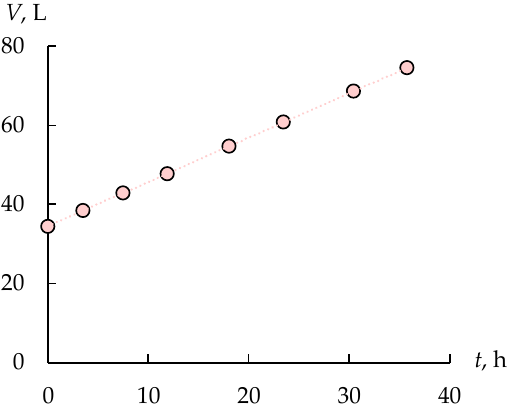
Figure 6. The solution volume in the concentrate tank during the first stage.